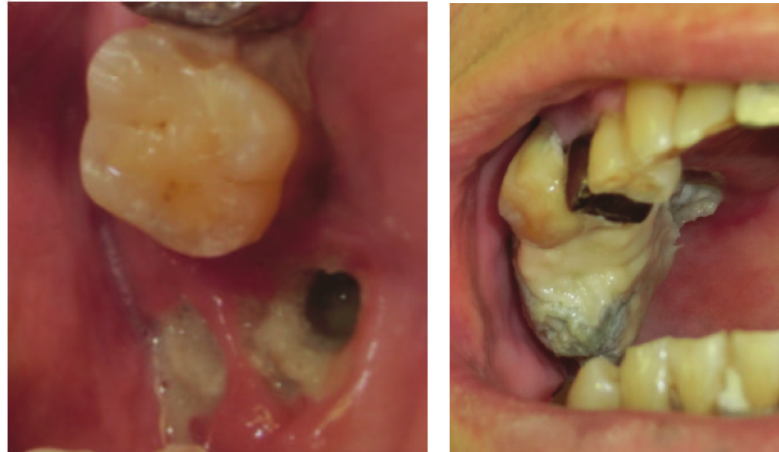
Figure 1: Intraoral examination.